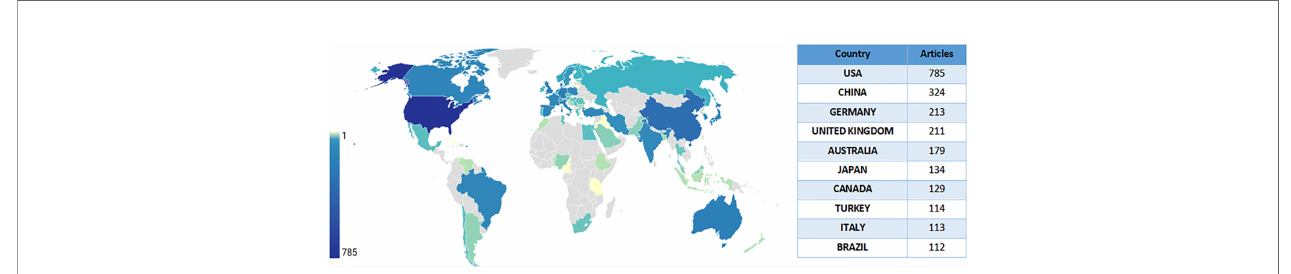
FIGURE 2 | A world map depicting the contribution of each country based on publication